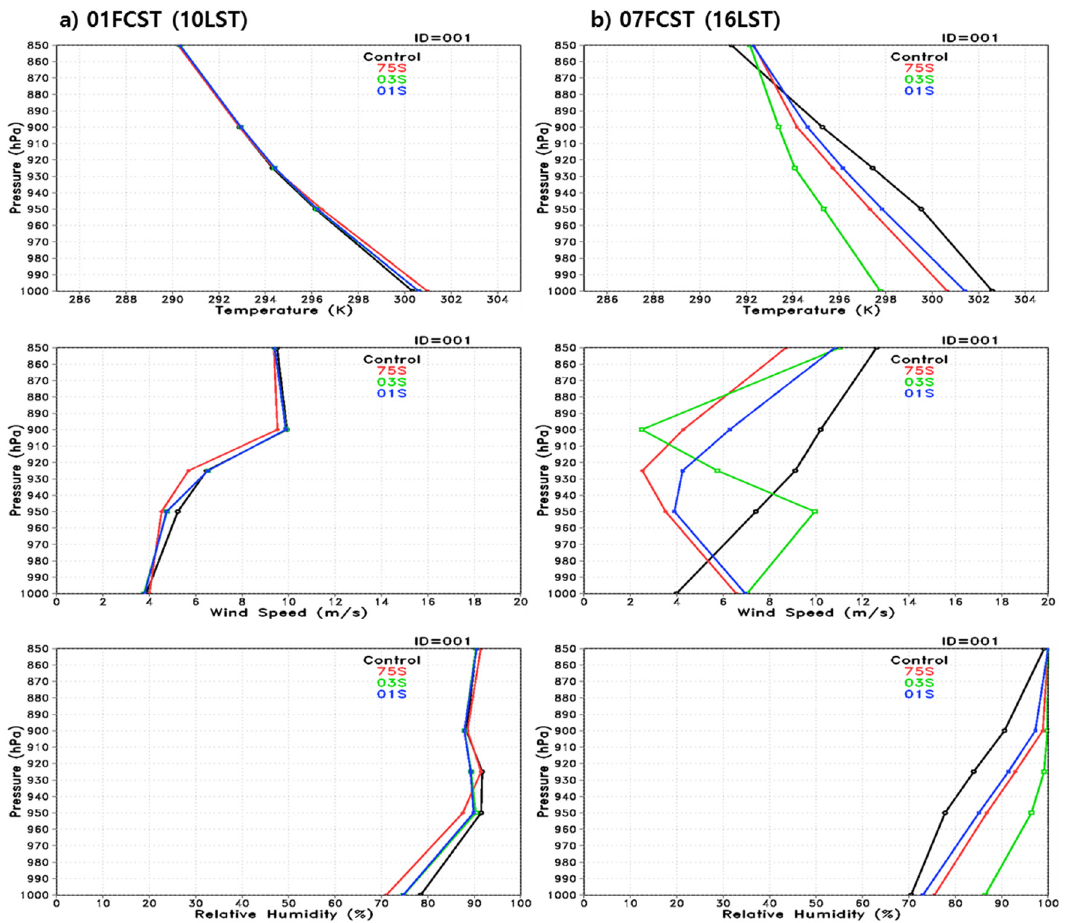
Figure 10. Vertical profiles of temperature, wind speed, and relative humidity on the Han River grid (37.521°N and 126.954°E) for ( a ) one-hour forecasting and ( b ) 7-h forecasting results. Note that 0000UCT is the same 0900 Local Sidereal Time (LST).